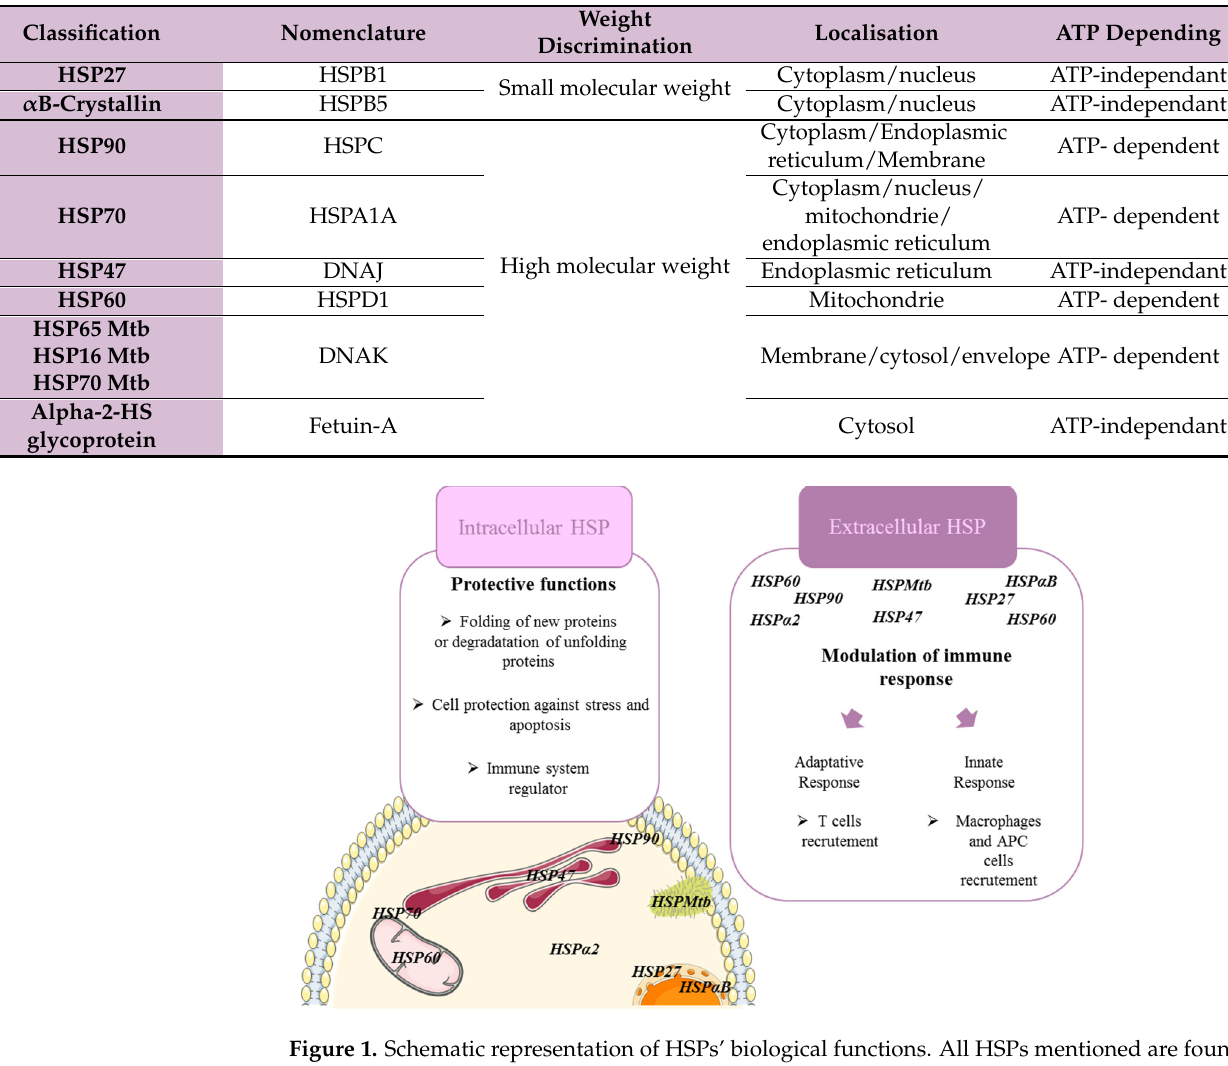
Table 1. HSP nomenclature and localization.